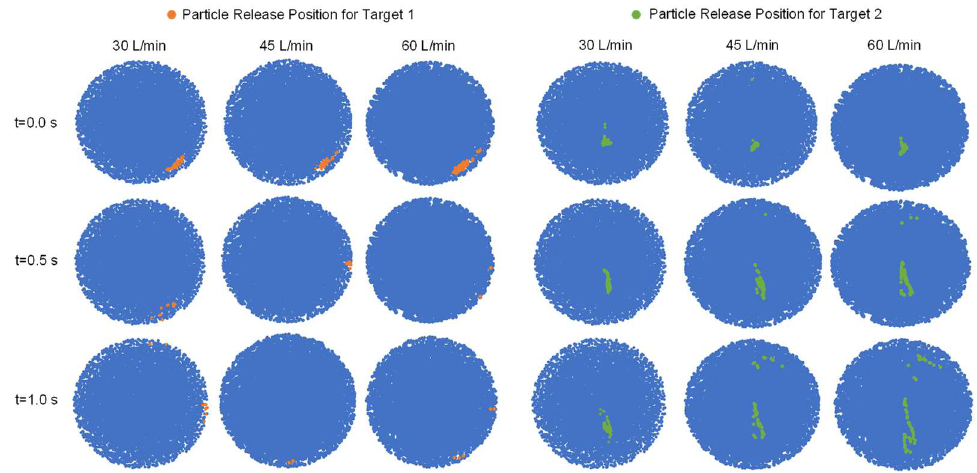
Figure 3. Particle release maps generated using conventional injection simulations with varied average inhalation flow rates (30, 45, and 60 L/min) and particle release times (0.0, 0.5, and 1.0 s).